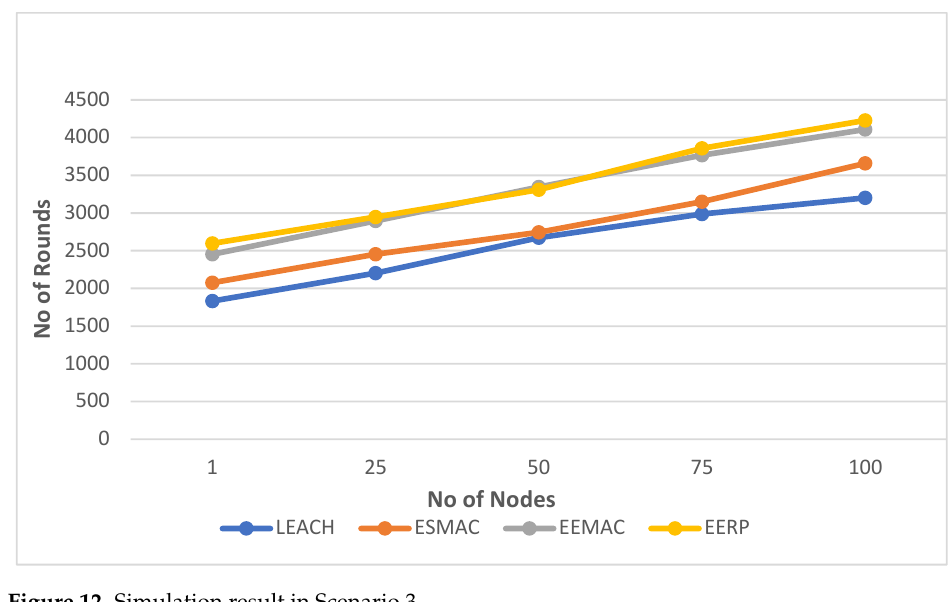
Figure 12. Simulation result in Scenario 3.